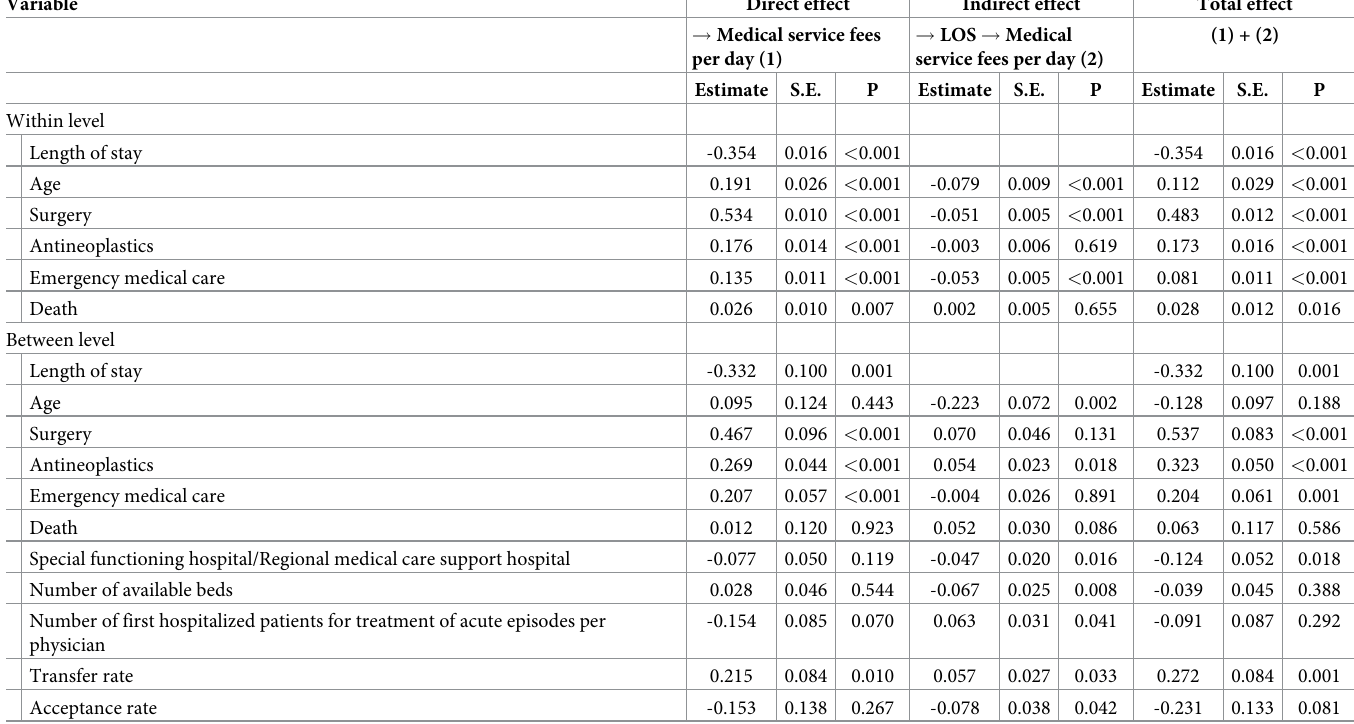
Table 3. Direct, indirect, and total effects on medical service fees per day with the standardized coefficients using multilevel structural equation modeling.